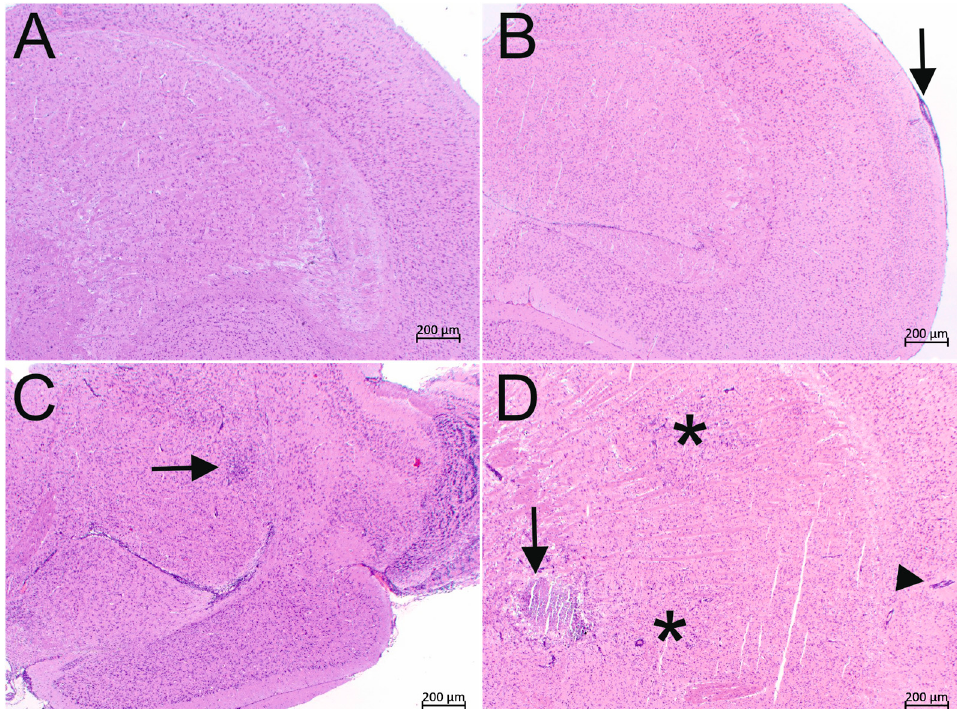
Figure 6. Histology (hematoxylin and eosin-stained paraffin sections) of N. caninum infection in brains of animals vaccinated with the Lm3Dx vector. Representative pictures of the Encephalitis grades 0–3 are shown. ( A ) Encephalitis grade 0 in an animal vaccinated with 1 × 10 7 CFU Lm3Dx_NcSAG1. No brain lesions are visible. ( B ) Encephalitis grade 1 in an animal vaccinated with 1 × 10 7 CFU Lm3Dx_NcSAG1. A focal mild lymphohistiocytic infiltrate is visible in the meninges (arrow) that slightly extends into the adjacent cortex. ( C ) Encephalitis grade 2 in an animal vaccinated with 1 × 10 5 CFU Lm3Dx_NcSAG1. A focal-extensive area of marked gliosis and lymphohistiocytic infiltration (arrow) is present in the caudate nucleus. ( D ) Encephalitis grade 3 in an animal inoculated with 10 6 CFU of the empty vector Lm3Dx. The brain is severely affected by multifocal lesions: Two focal-extensive areas of gliosis and lymphohistiocytic infiltration (asterisks) and a large granuloma with central necrosis (arrow) are present in the caudate nucleus. Additionally, lymphohistiocytic perivascular cuffs (arrowhead) are present in the cortex.